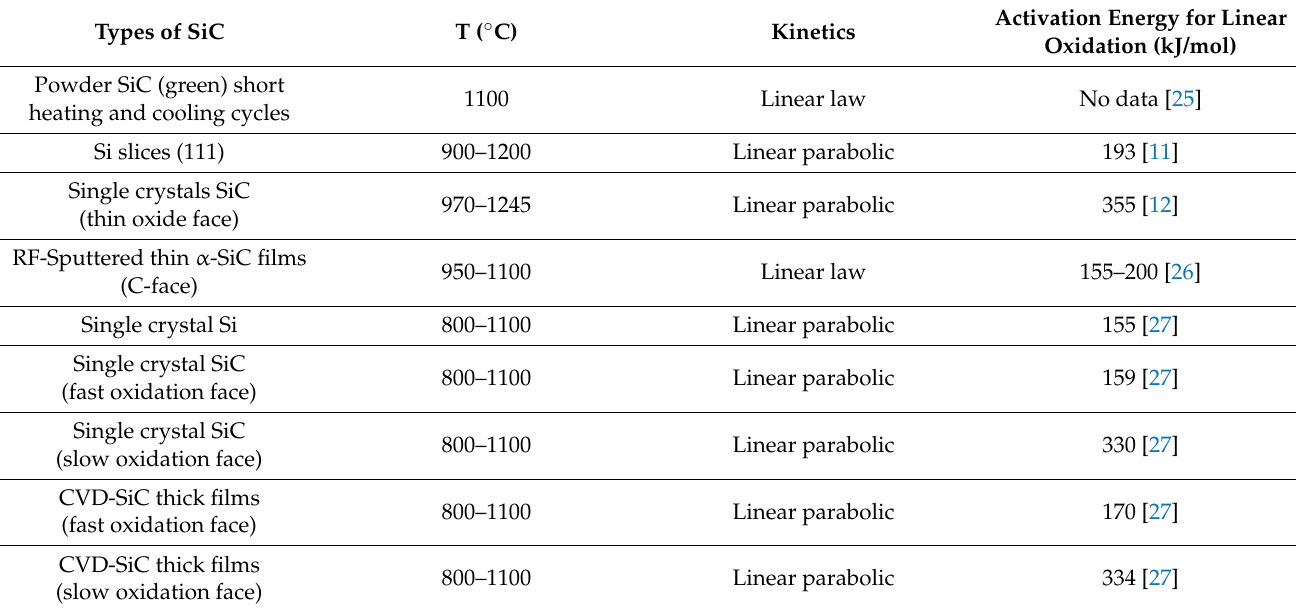
Table 1. Activation energies for linear oxidation of SiC in dry atmosphere.